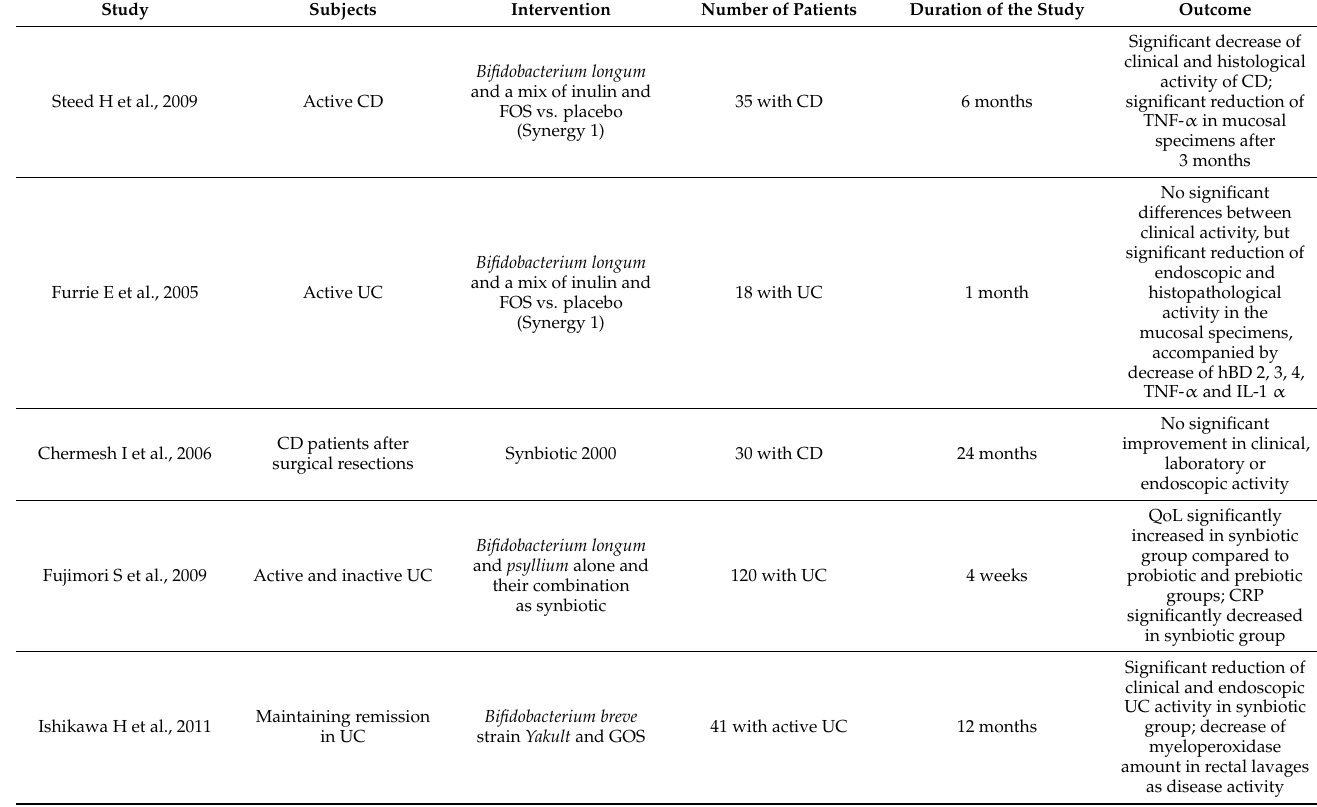
Table 3. Studies on synbiotics in